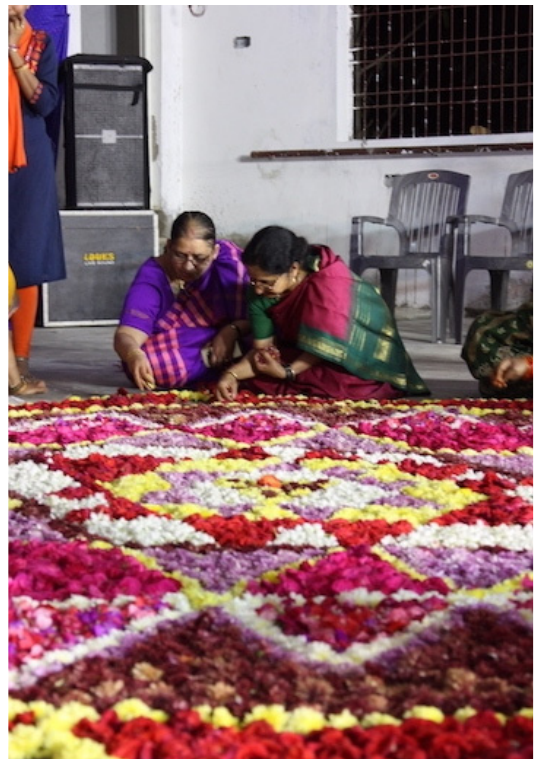
Figure 12. Decorating the Ś r ī cakra. Credit: author.